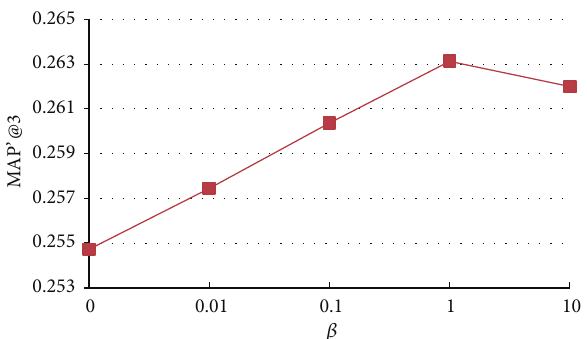
Figure 6: Impact of size of similar seekers on accuracy of 1 model Seeker source n 1